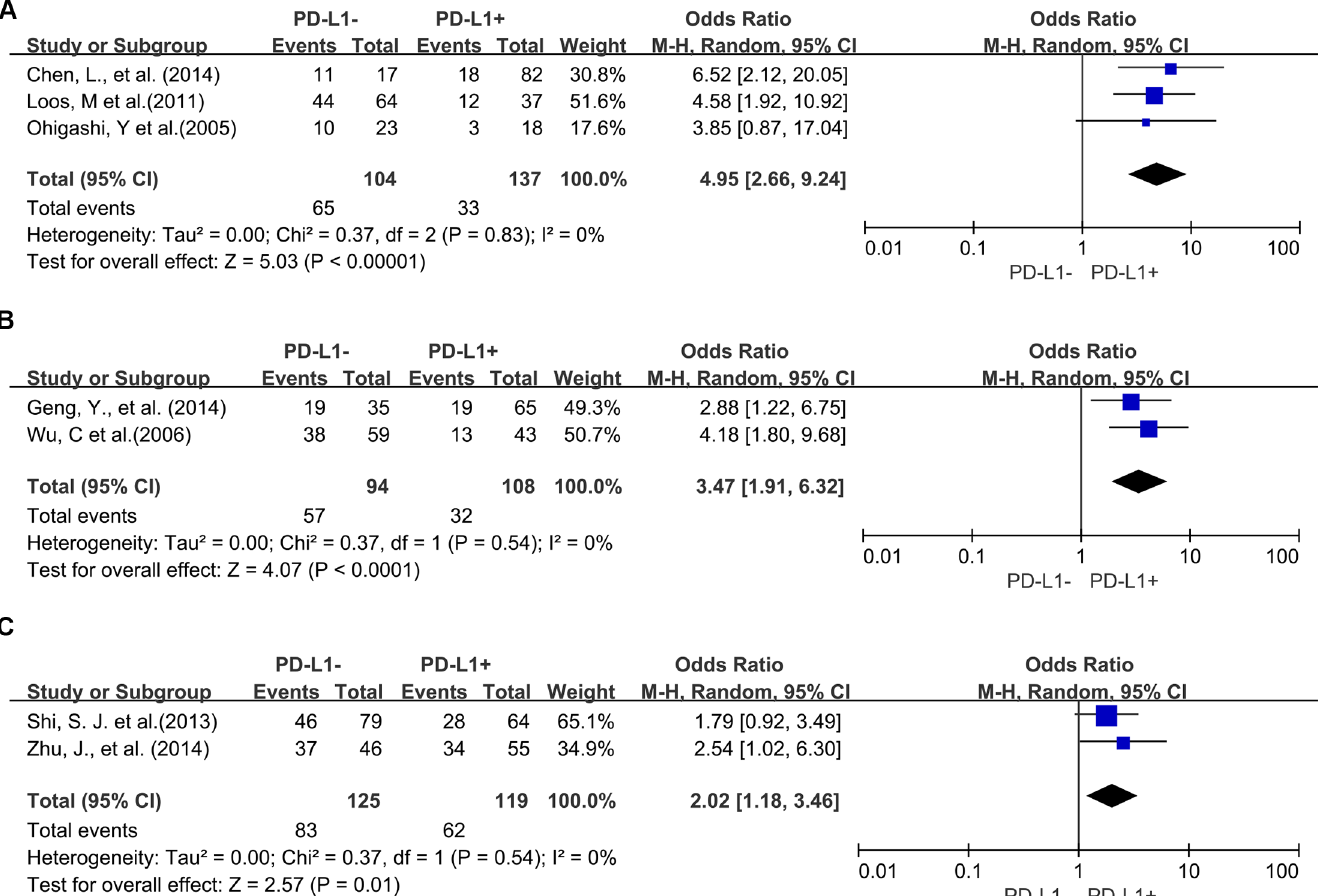
Fig 5. Forest plot describing subgroup analysis of the association between PD-L1 expression and 5-year OS of patients with esophageal cancer (A), gastric cancer (B) and colorectal cancer (C).